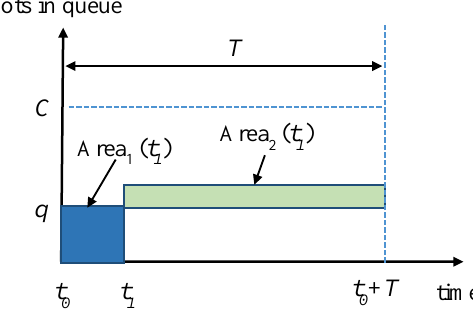
Figure 2. Changes in waiting time when the lots are loaded at time t 1 . The saved wait time is Area 2 ( t 1 ) − Area 1 ( t 1 ).